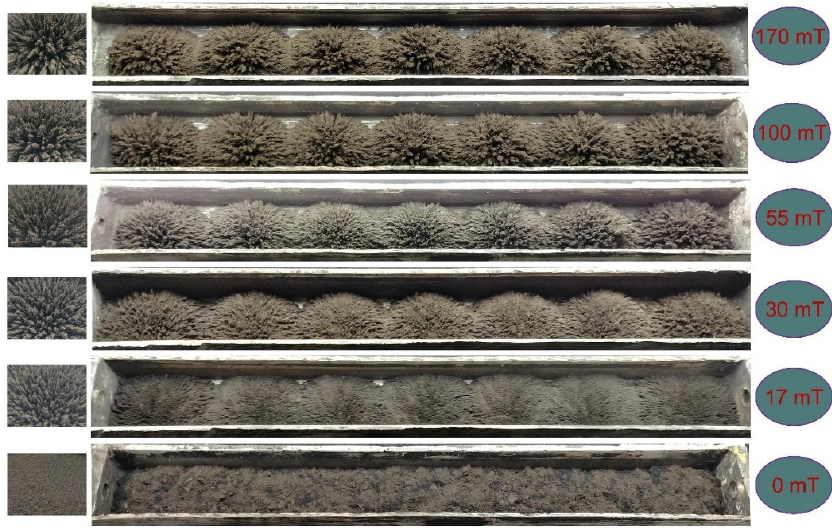
Figure 7. Photograph showing CoFe 2 O 4 @Ag 2 O nanocomposites arranged in a photochemical reaction with different strengths of magnetic field. Reprinted from Jiang et al. [119] with permission from Elsevier.